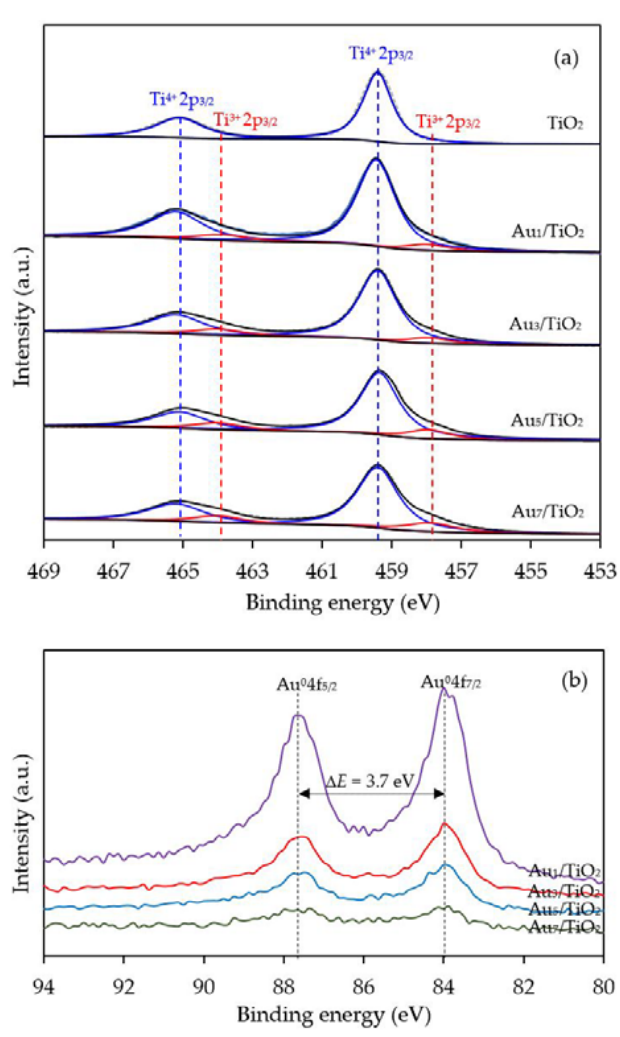
Figure 5. Representative c spectra of the ( a ) Ti2p and ( b ) Au4f of the TiO 2 and different Au x /TiO 2